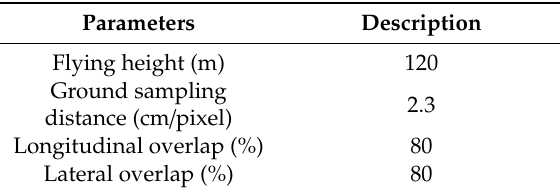
Table 3. Unmanned aerial vehicle (UAV) flight